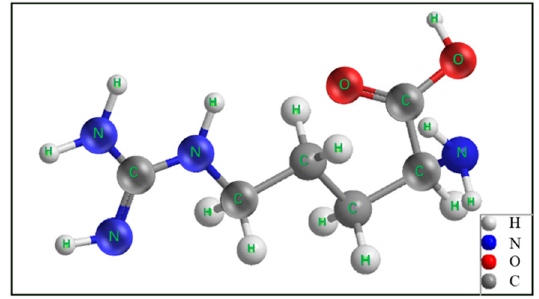
Figure 1. Molecular structure of L ‐ arginine.